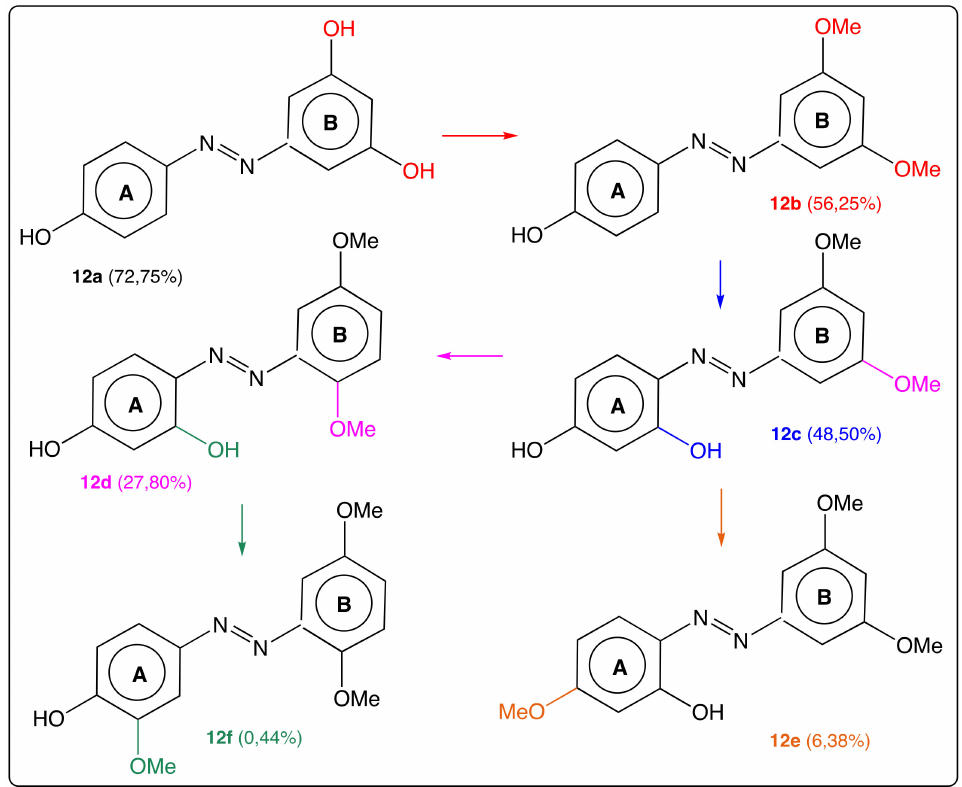
Figure 13. Structure of AZO-ST 12a – f (and percentage of tyrosinase inhibition) [49].